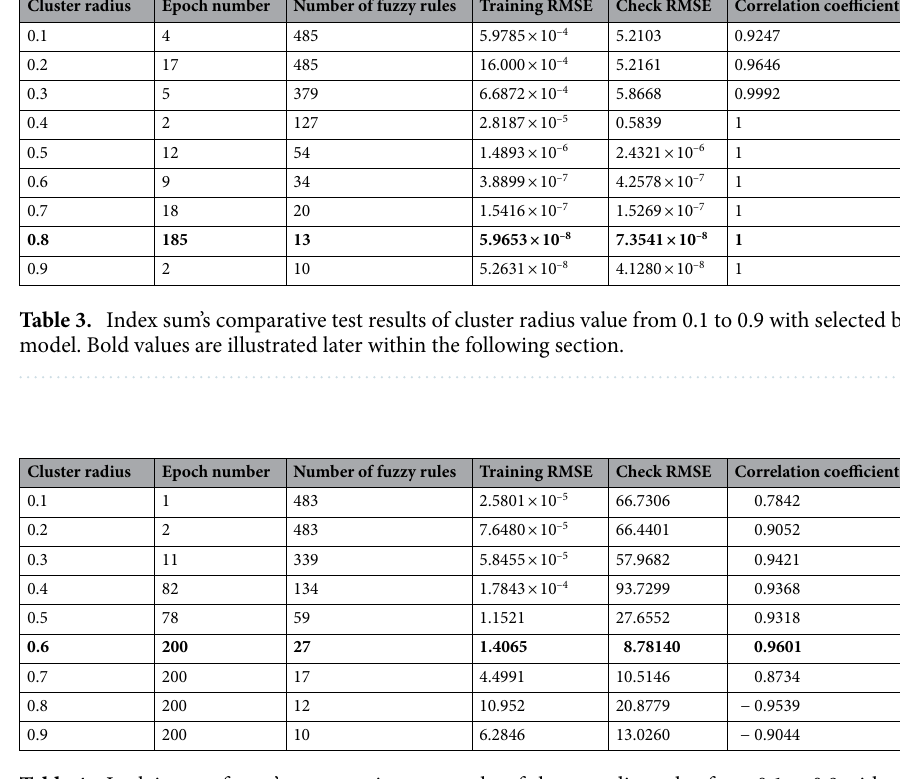
Table 4. Leak impact factor’s comparative test results of cluster radius value from 0.1 to 0.9 with selected best fitted model. Bold values are illustrated later within the following section.